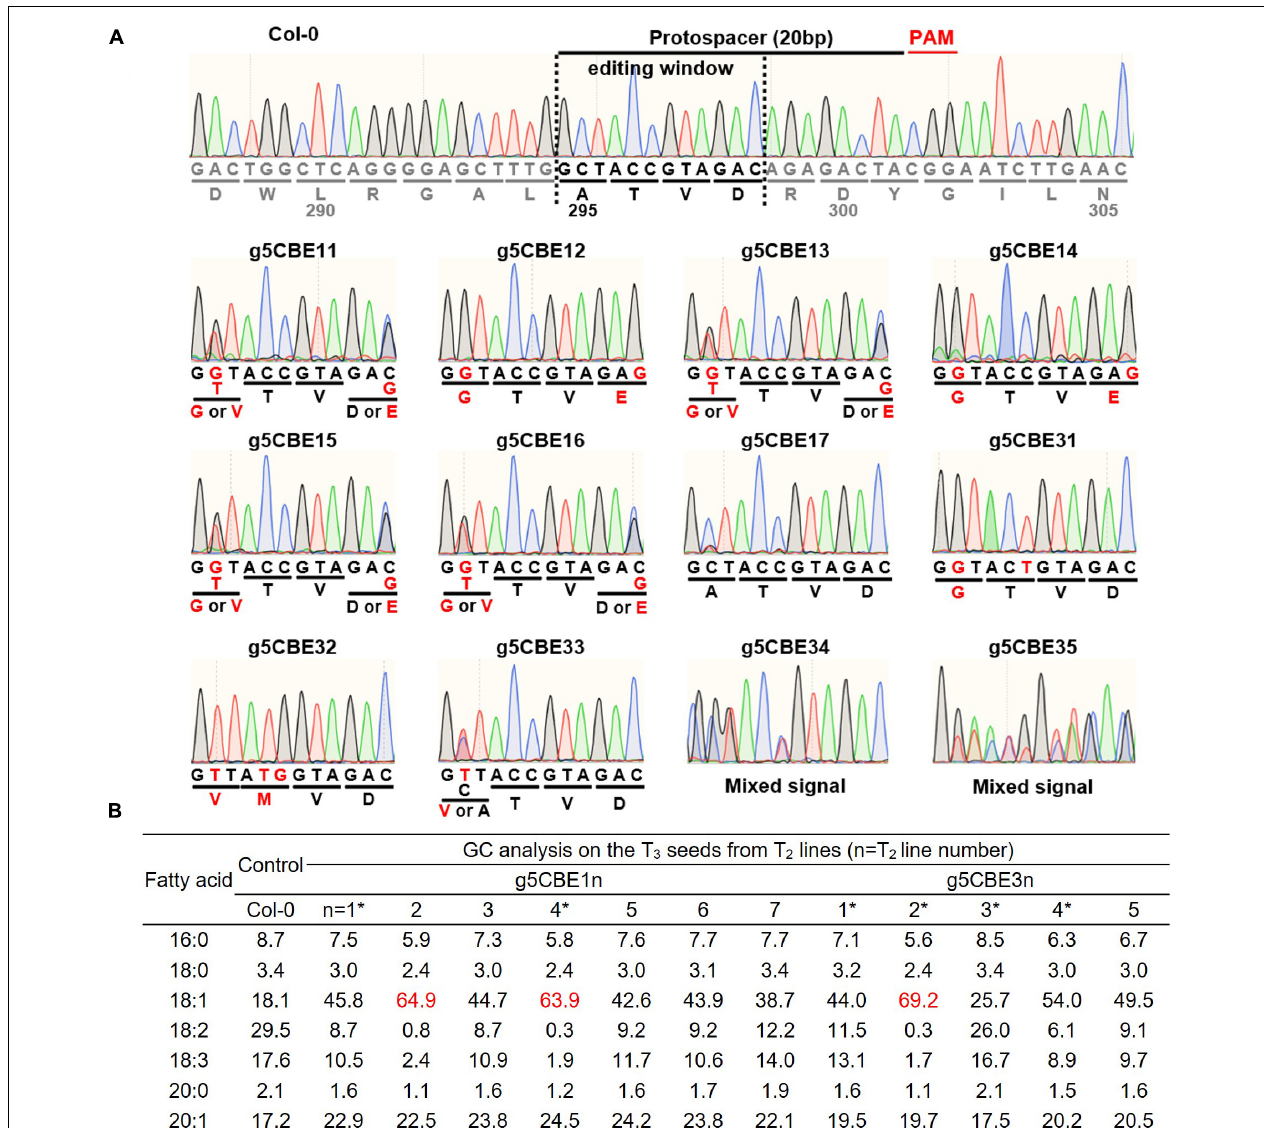
FIGURE 2 | Characterization of the FAD2-targeting CBE-transgenic lines. (A) Chromatogram results from Sanger sequencing for FAD2 genotyping within editing windows in the T 2 plants. The editing window is specified in the upper Col-0 panel. Red letters indicate altered DNA and amino-acid sequences. (B) Analysis of fatty acid compositions of transgenic lineages. Red-colored numbers denote the three most increased oleic acid contents observed among T 2 plants analyzed. Asterisks (*) indicate the representative T 2 transgenic lines that were progressed to the next T 3 generation for further